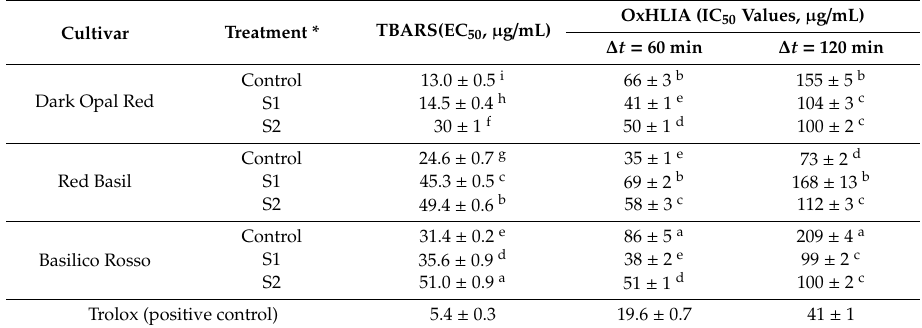
Table 5. Antioxidant activity of the tested basil cultivars in relation to salinity level (mean ± SD, n = 3).